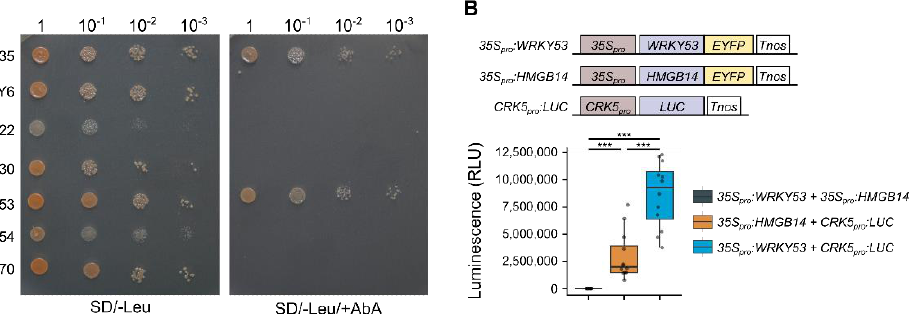
Figure 2. ( A ) Identification of interaction between CRK5 promoter and six WRKY senescence-related transcription factors (WRKY6, WRKY22, WRKY30, WRKY53, WRKY54, WRKY70). The analysis was performed by Matchmaker Gold Yeast One-Hybrid System. Single-deficiency (SD/ – Leu) screening assay was performed to estimate yeast transformation efficiency, while the addition of 200 ng/mL aureobasidin allowed for identifying potential binding partners. The combination of p53-AbAi and pGADT7-p53 was used as a positive control. ( B ) Transient transactivation luciferase reporter assay. The study was based on the transient transformation of N.benthamiana leaves with two genetic constructs simultaneously: 1) prom35S-WRKY53 and prom35S-HMG At2g34450 (negative control without luciferase activity), 2) prom35S-HMG promCRK5-LUC, 3) prom35S-WRKY53 and promCRK5-LUC. Mean values of luciferase activity (RLU) were derived from 12 tobacco plants ( n = 12). Dots represent individual observations. Asterisks indicate a significant difference according to the t -test at level p < 0.001 (***).